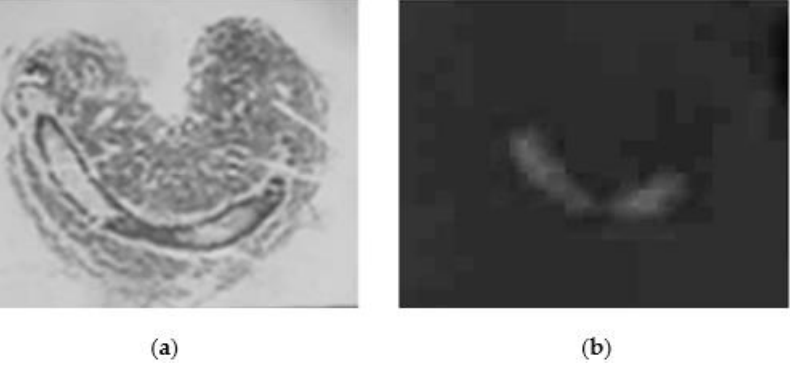
Figure 3. Slide of worker-fate larvae honeybees obtained by cryostat. ( a ) Larva stained by hematoxylin-eosin method; ( b ) larva obtained by zymography treatment; the proteolytic activity is white.